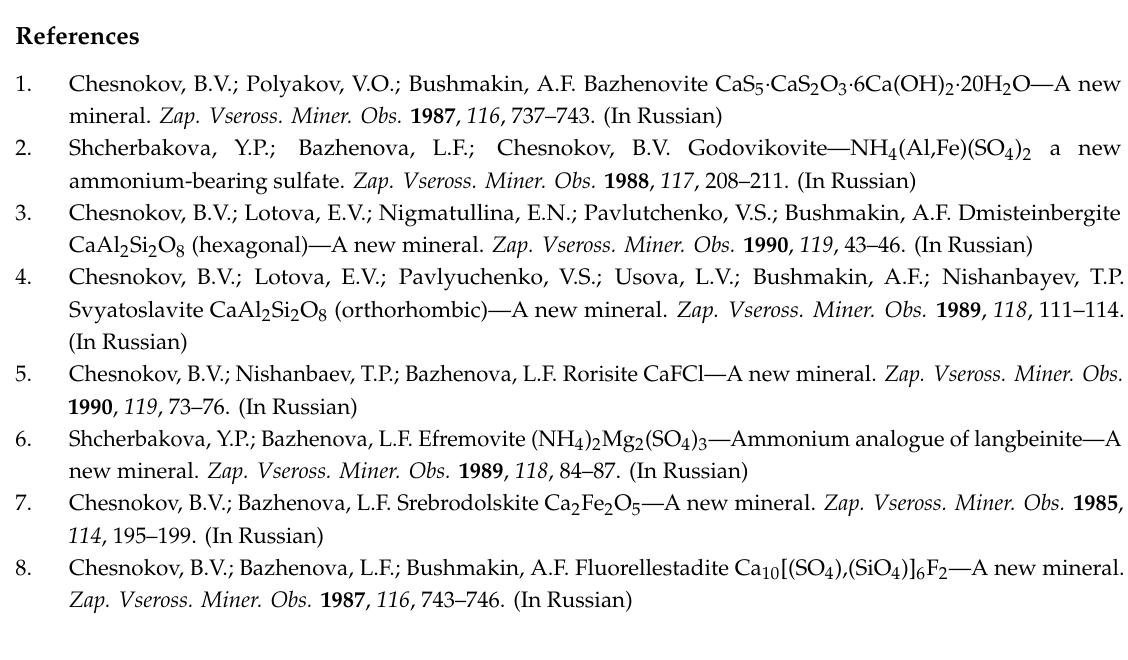
Figure S1: The dependencies of unit-cell parameters of HT modification of NH 4 MgCl 3 · 2H 2 O, Table S1: The refined unit-cell parameters for NH 4 MgCl 3 · 6H 2 O phase at di ff erent temperatures, Table S2: The refined unit-cell parameters for HT phase of NH 4 MgCl 3 · 2H 2 O, at di ff erent temperatures, Table S3: The refined unit-cell parameters for (NH 4 ) 2 Fe 3 + Cl 5 · H 2 O phase at di ff erent temperatures, Table S4: Bond-valence analysis (v.u. = valence units) for (NH 4 ) 2 Fe 3 + Cl 5 · H 2 O phase, Table S5: Approximation equations for NH 4 MgCl 3 · 6H 2 O phase and its HT modification, Table S6: Approximation equations for (NH 4 ) 2 Fe 3 + Cl 5 · H 2 O phase, NH 4 MgCl 3 · 6H 2 O.CIF: crystallographic Information file (CIF) for the crystal structure of NH 4 MgCl 3 · 6H 2 O, (NH 4 ) 2 FeCl 5 · H 2 O.CIF: crystallographic Information file (CIF) for the crystal structure of(NH 4 ) 2 FeCl 5 · H 2